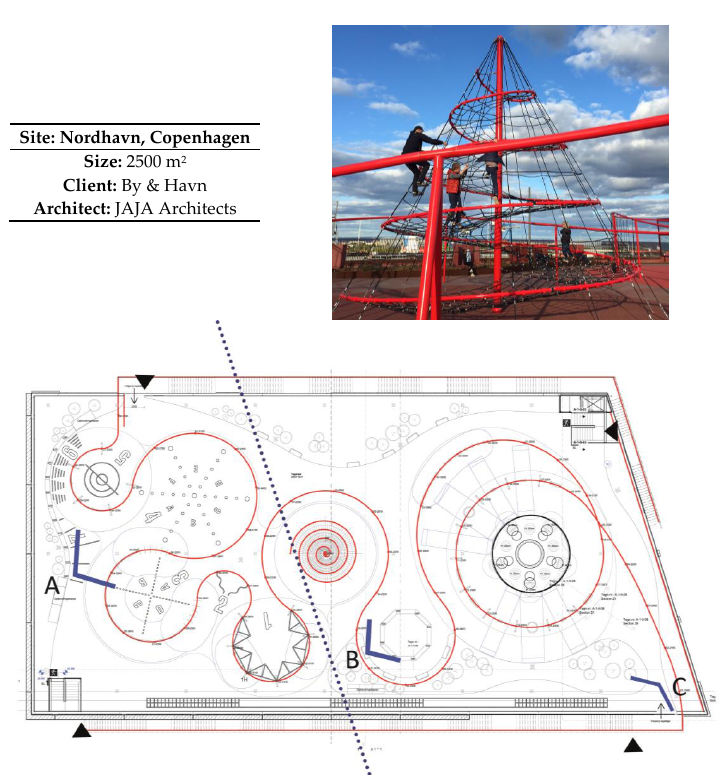
Figure 1. Overview of the Lüders parking roof. In order to make manageable observations, the space was divided into three sub-areas. Sub-areas A and B cover the roof, while sub-area C covers the staircase. The angle explains the field of view during the observations. Int. J. Environ. Res. Public Health 2018 , 15 , x